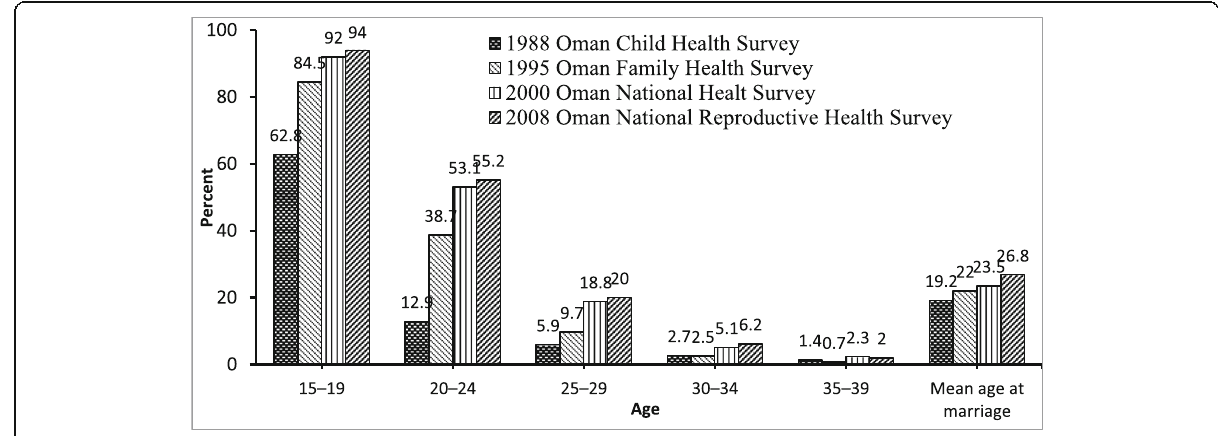
Fig. 4 Age-specific percentage of single women and mean age at marriage (SMAM) of women, 1988 – 2008. Source: Islam